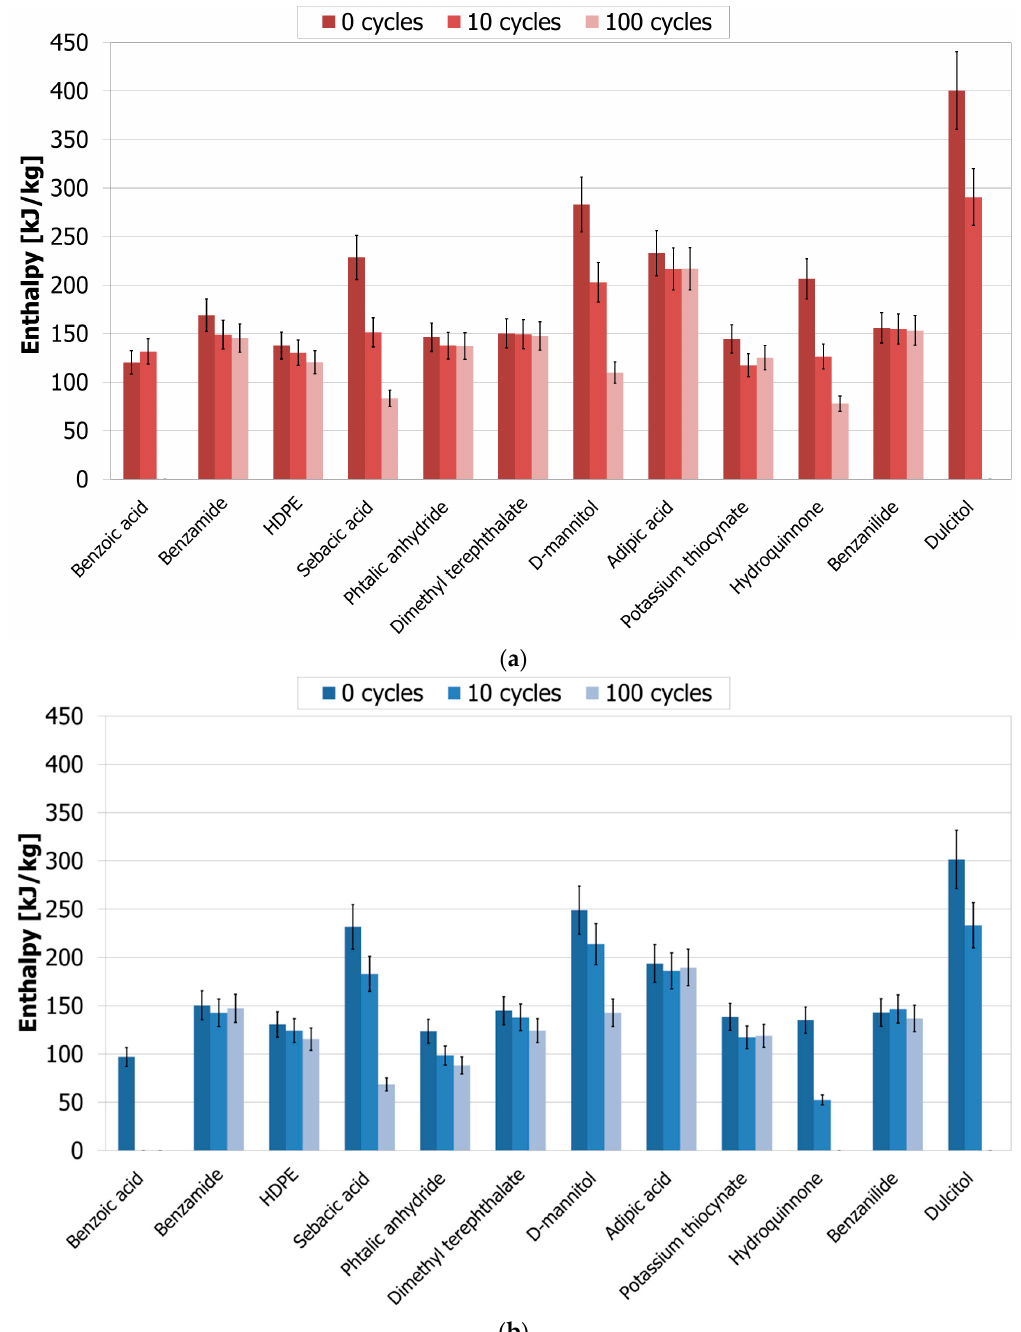
Figure 2. Phase change enthalpy: ( a ) melting; ( b ) solidification.